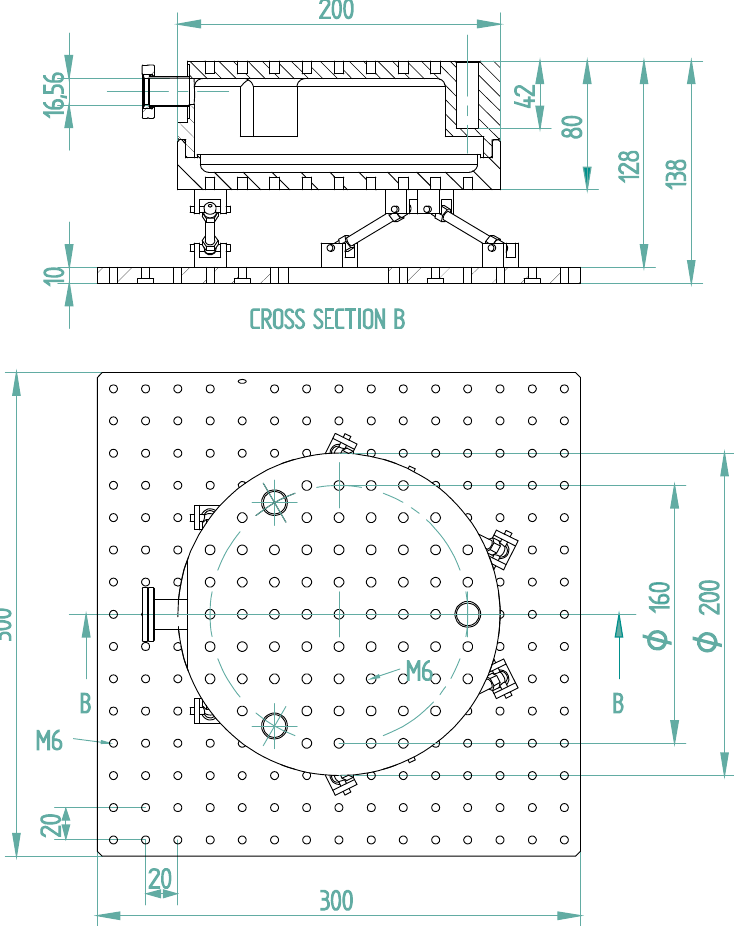
Figure 2. Technical drawing of the LN 2 vessel: Top and bottom parts.